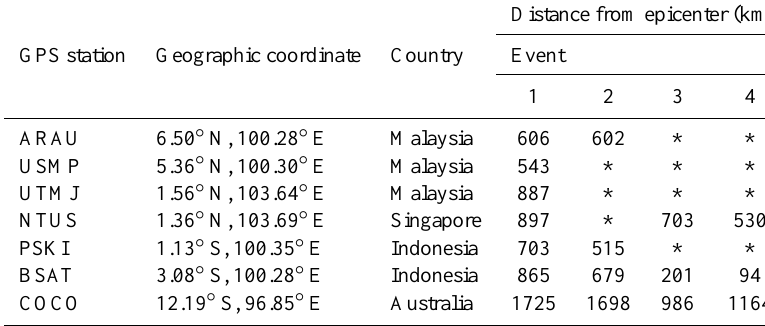
Table 2. The geographic coordinates of the GPS stations and their distances from the epicenters. Distance from epicenter (km) GPS station Geographic coordinate Country